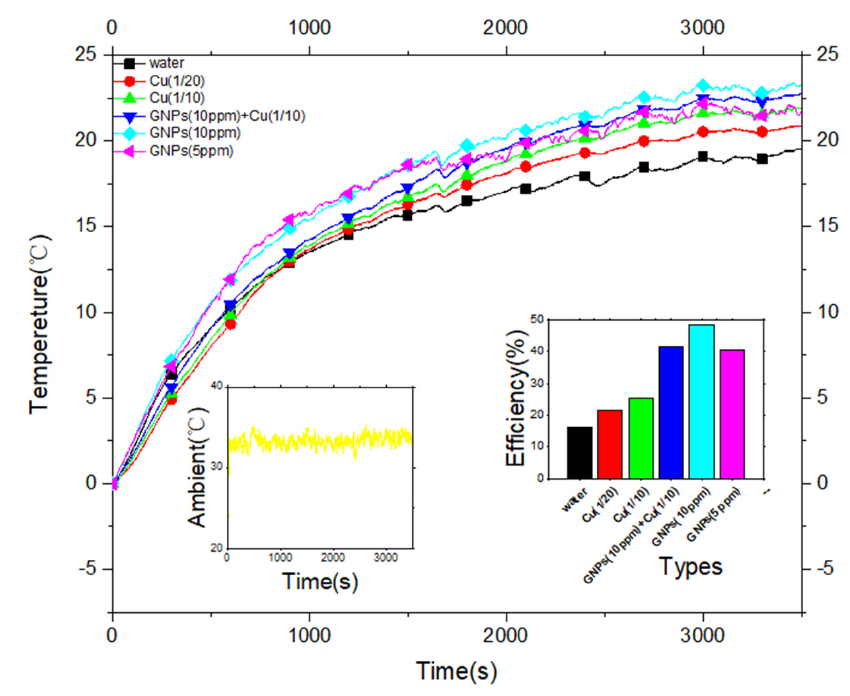
Figure 16. Predicted solar energy absorption efficiency and experimental results of Au-Al 2 O 3 hybrid nanofluid.